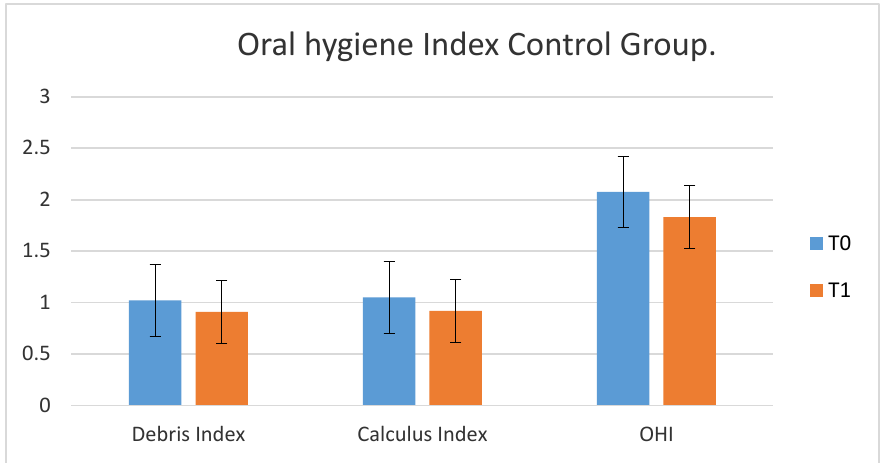
Oral hygiene Index Control Group.